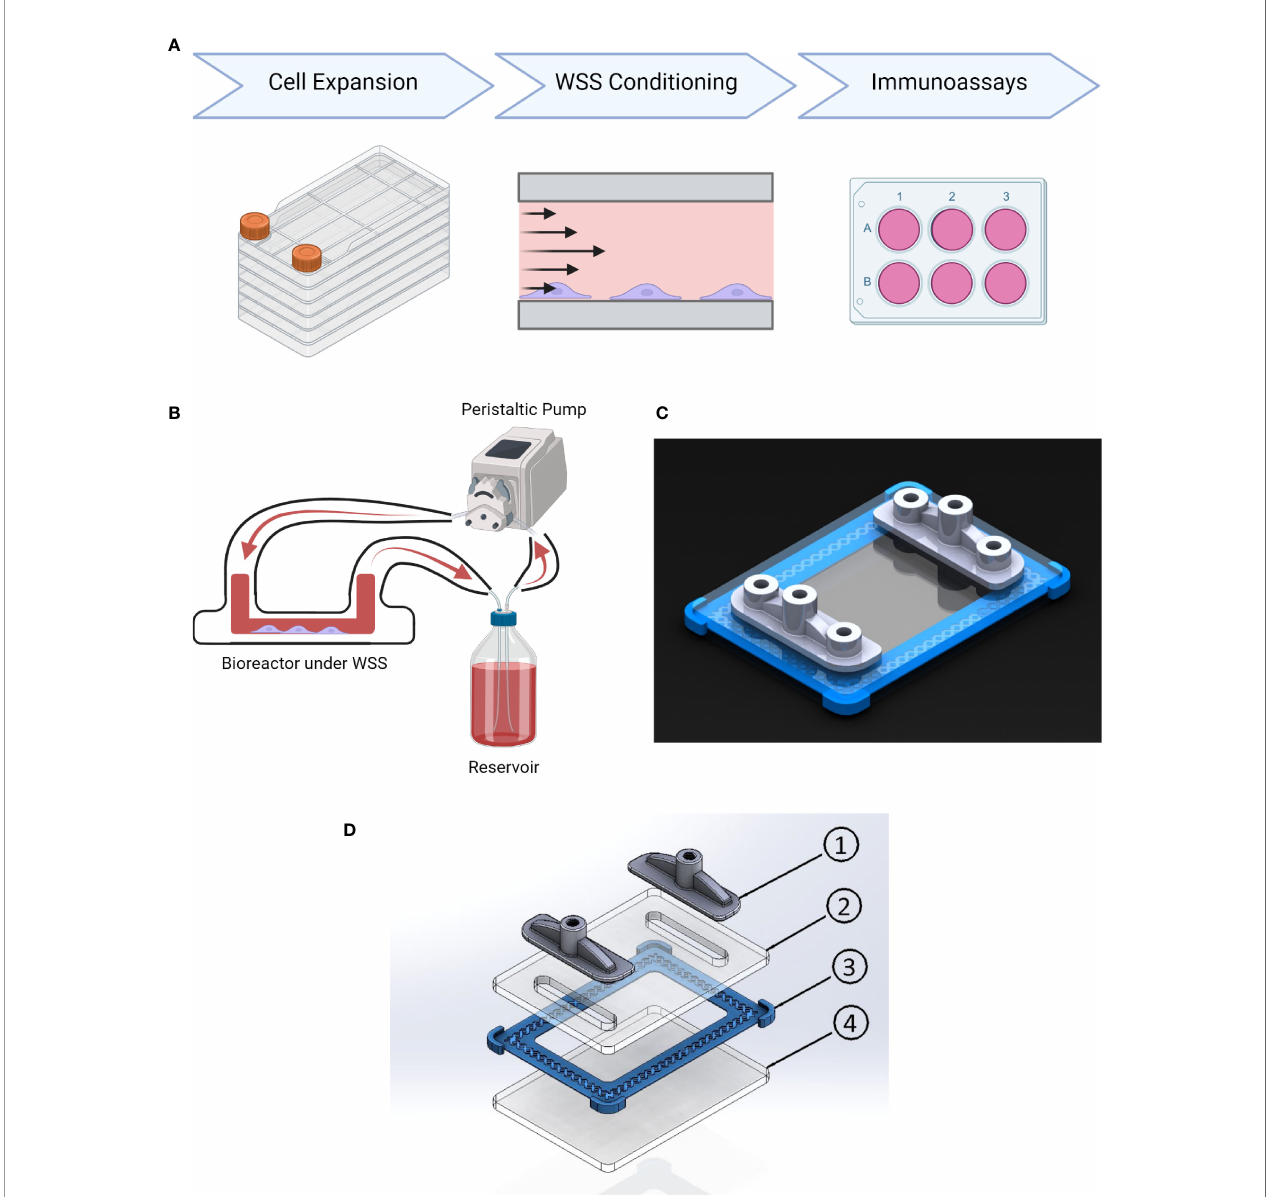
FIGURE 1 | Conditioning platform design and procedure. (A) Experimental timeline. MSC undergo cell expansion in large volume tissue culture plastic under xeno- free conditions using cGMP-comparable methods and reagents. Next WSS conditioning is performed on adherent MSC in the parallel plate bioreactor at 4, 8, or 12 dyne/cm 2 for 3 hrs. The resulting cells are then immunoassayed for their ability to modulate in fl ammation in a panel of assays. (B) Schematic of platform con fi guration, including PPB, media reservoir, and peristaltic pump. (C) Rendering of parallel-plate bioreactor displaying transparent PMMA plates fabricated using a CNC mill, 3D-printed gasket (blue), and 3D-printed inlet/outlet manifolds with sampling ports (grey). (D) Schematic of parallel plate bioreactor: (1) 3D Printed Inlet/ Outlet Ports, (2) PMMA Top Plate, (3) 3D Printed Gasket, (4) PMMA Base